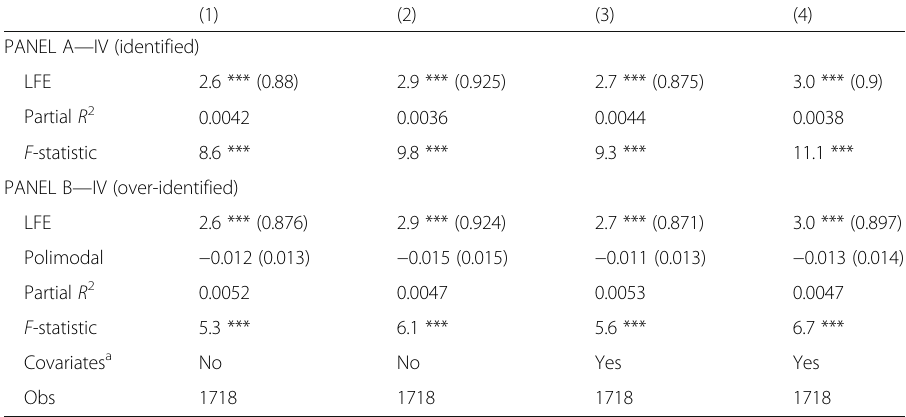
Table 7 The effect of educational reform on enrollment rate. 2SLS estimates — first stage (Eq.